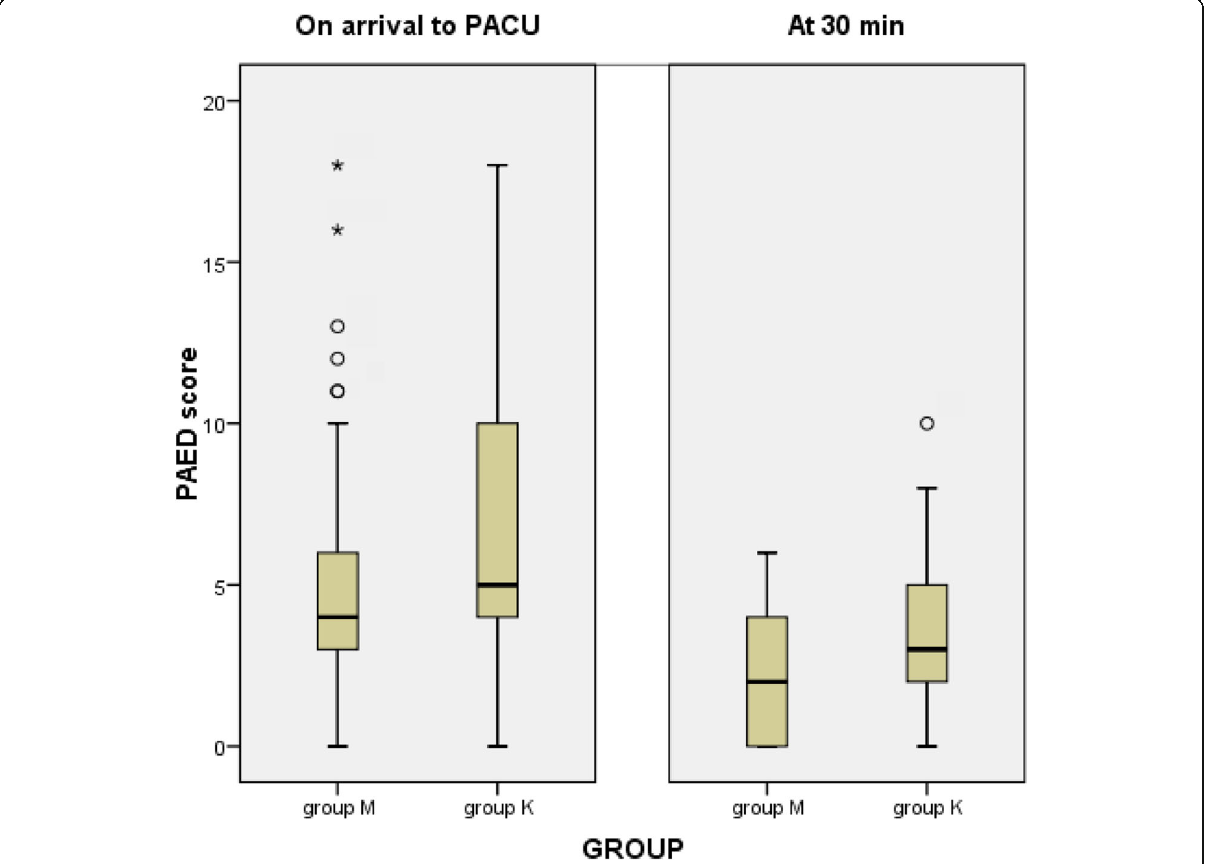
Fig. 3 Comparing both groups as regards PAED score on arrival to PACU and after 30 min. The median is expressed by the middle black solid line, the upper and lower margins of each box are the IQR, the whiskers are the maximum and minimum values, asterisks represent the number of patients with outlier data